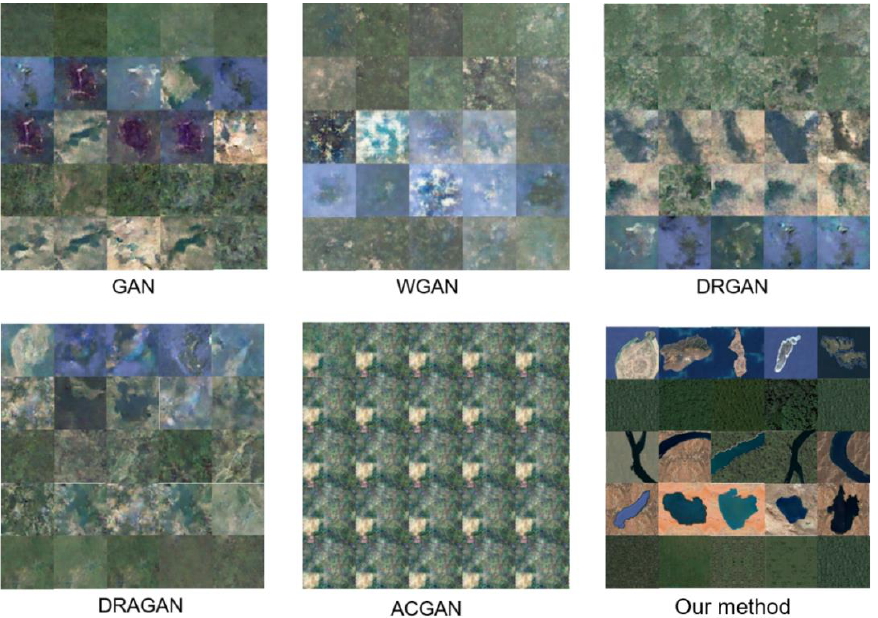
Figure 7. Generation results of GANs and our method.